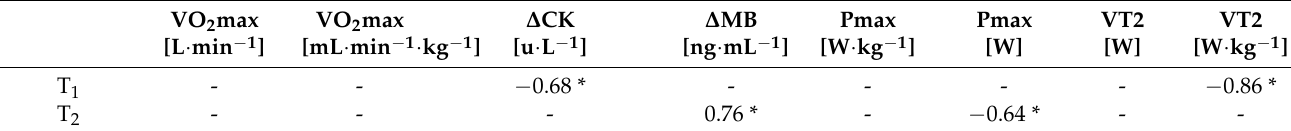
Table 4. Partial correlation coefficients between the race time difference and independent variables among the two regression